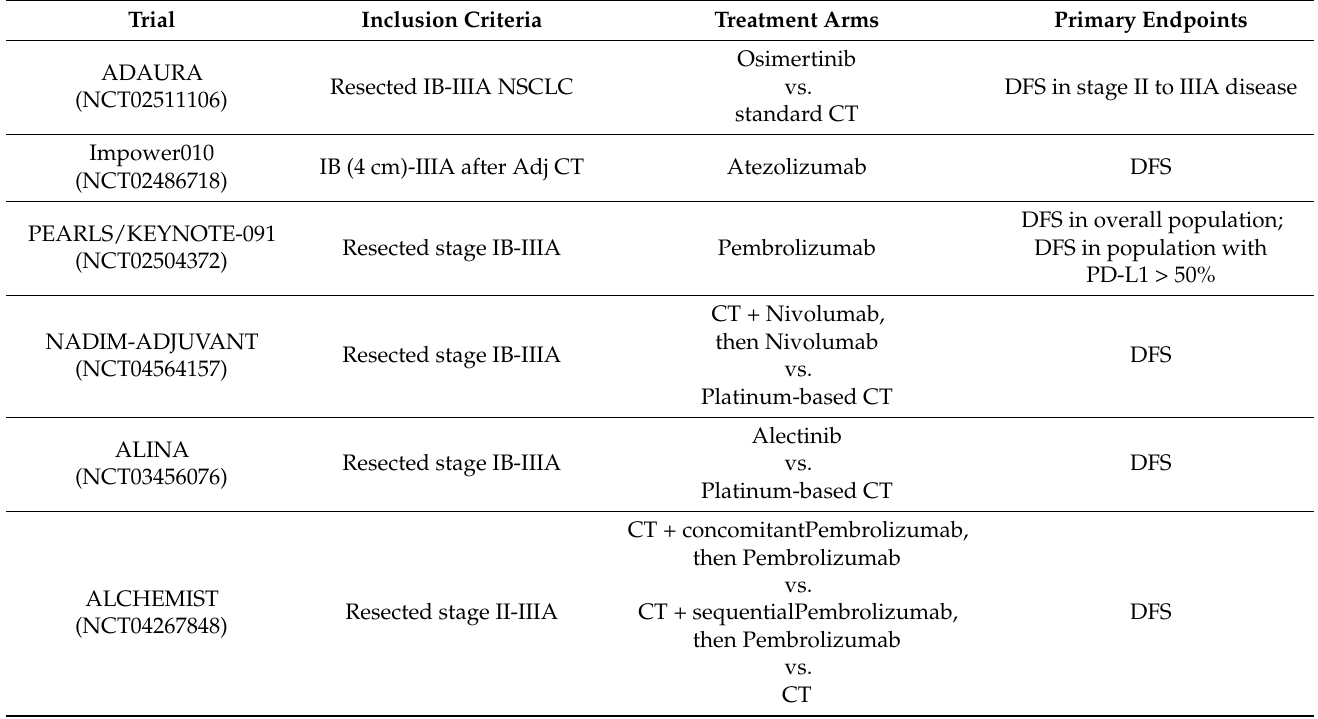
Table 2. Main adjuvant Immunotherapy/targeted therapy